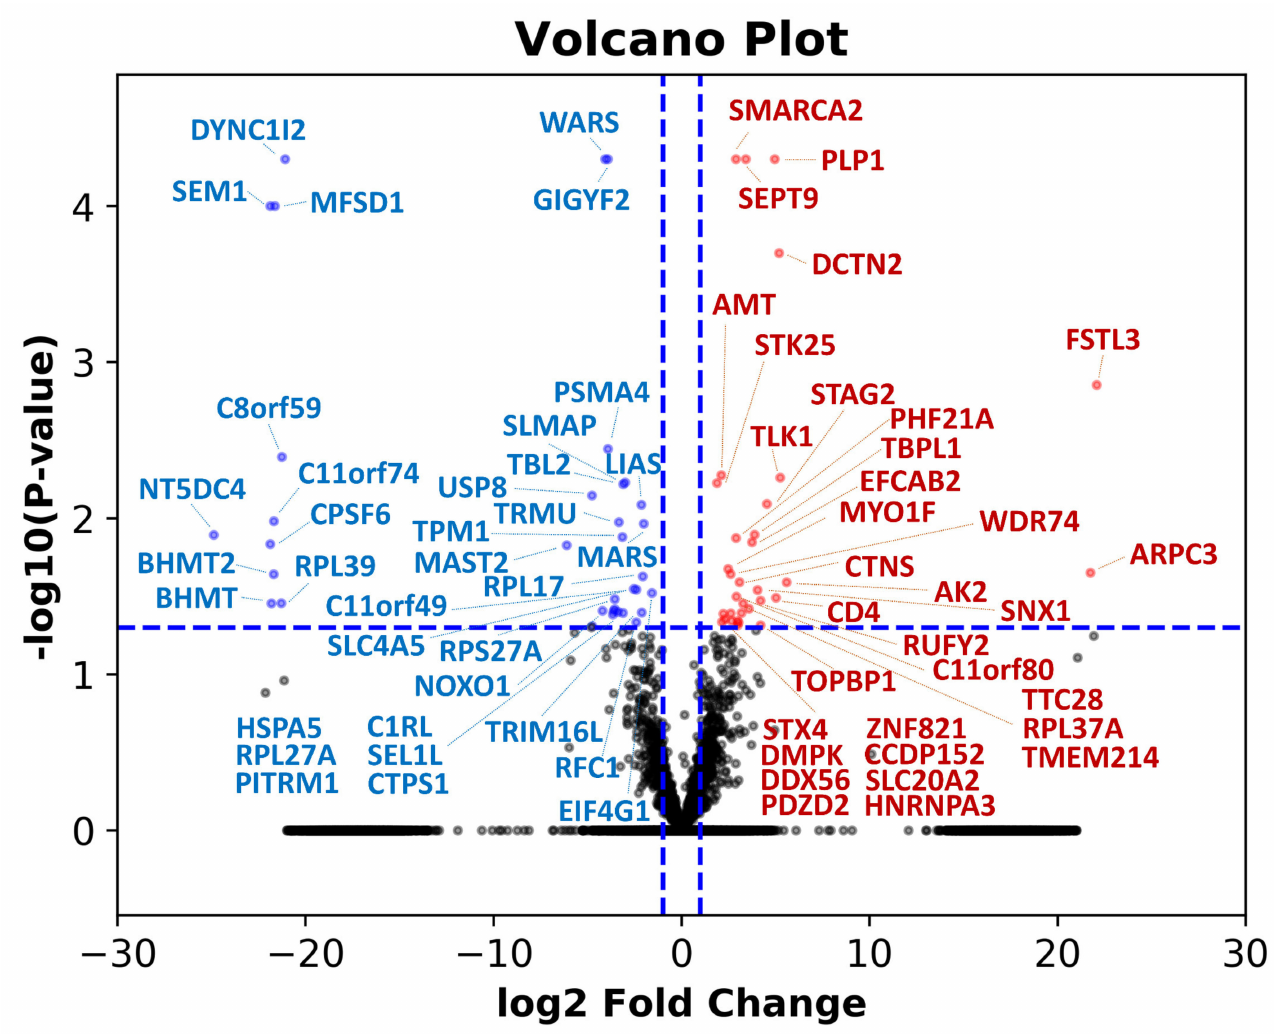
Figure 8. Differential gene expression patterns between GSTM3 inhibited or negative control of T98G glioblastoma cells. The volcano plot of log2 (fold change) versus − log10 ( q -value) reveals differentially upregulated (right upper quadrant) and downregulated (left upper quadrant) genes expressed in GSTM3-inhibited cells versus negative control cells. Genes with q-values >0.05 and >2-fold changes are plotted in blue (downregulated) and red (upregulated),